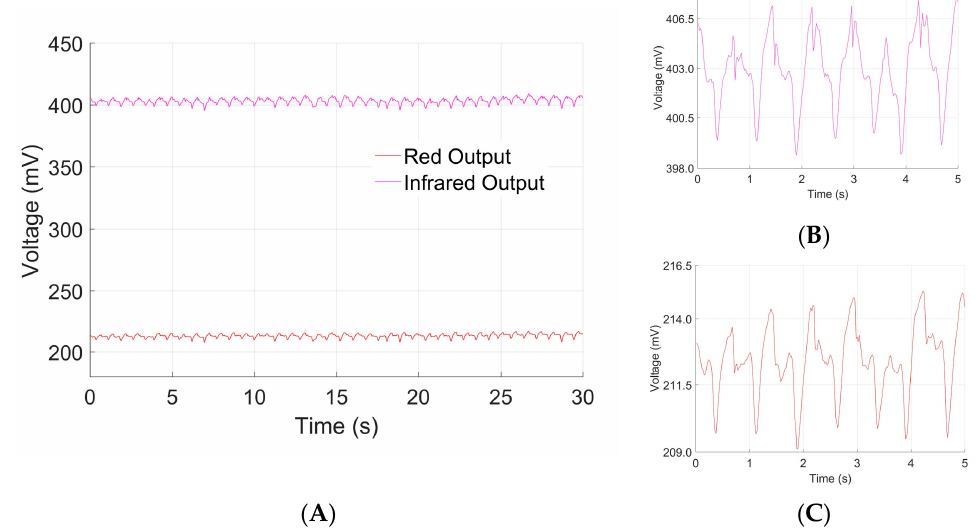
Figure 3. ( A ) The pulse oximetry sensor outputs a representative raw plethysmography waveform that shows the output from both infrared and red wavelengths. Magnified views of ( B ) infrared and ( C ) red are presented to show smaller scale features. are presented to show smaller scale features.